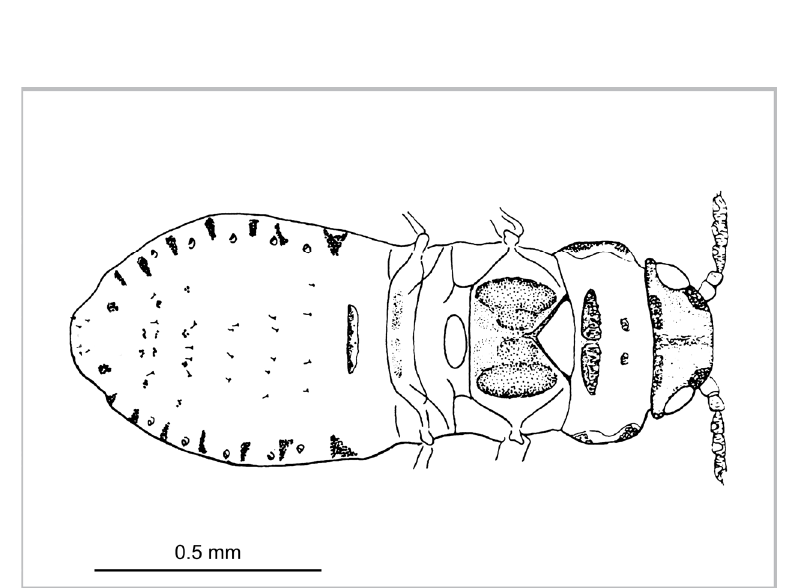
Fig. 23. Adelges (Sacciphantes) viridis (Ratzeburg, 1843), sexupara (after Carter 1971, redrawn and modified from Heie 2004).